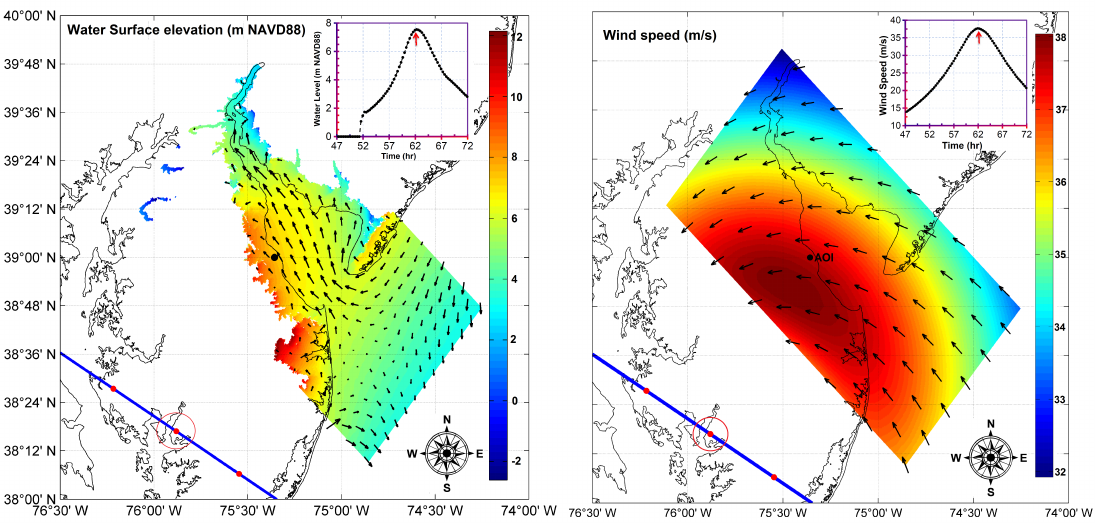
Figure 10. Wind speed (m/s) and direction snap-shot ( right ) and storm surge elevation (m NAVD88) snap-shot ( left ) from Nested2 model at the time of the peak surge. Time history of water level ( top left ) and wind speed ( top right ). Synthetic hurricane track is shown in blue color with the hourly location of the storm center in red filled